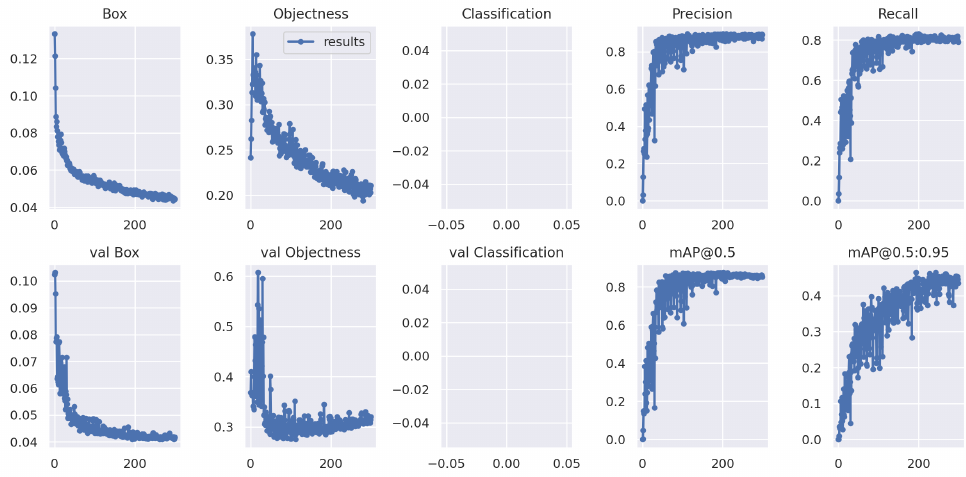
Figure 6. Training process diagram of self-made karez dataset based on YOLOv5, EPOCHS =